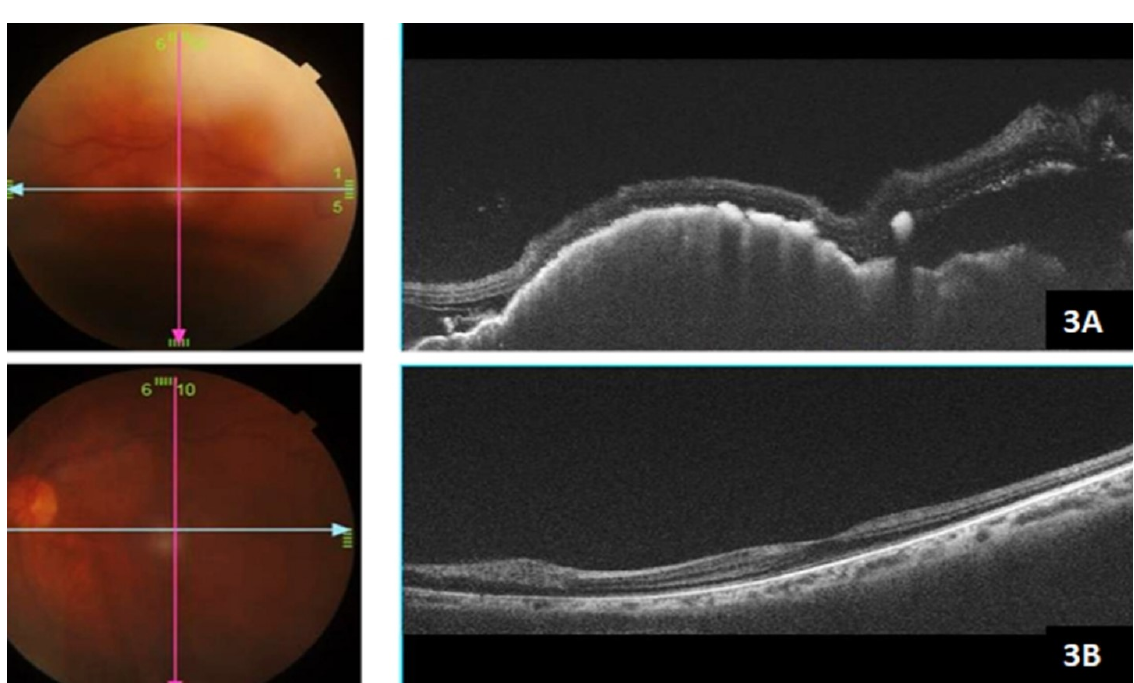
Figure 3: A) Right-eye OCT line scan passing through the temporal aspect of the fundus showed altered retinal contour, and a subretinal hyporeflective space with few high reflective lesions subretinally. It also showed lumpy-bumpy appearance of the retinal pigment epithelium and an elevated choroidal mass lesion beneath it. B) The left showed a normal foveal OCT